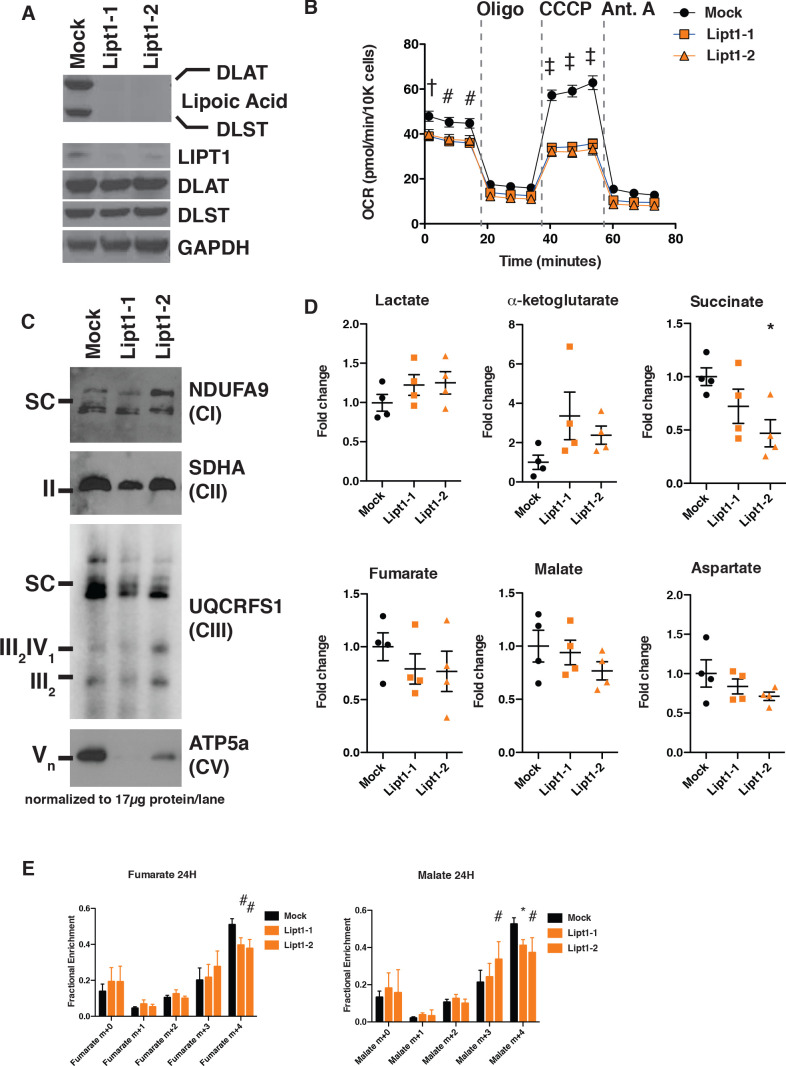
MtFAS mutant phenotypes are not recapitulated by loss of lipoic acid alone.(A) Immunoblot for the indicated proteins in whole cell lysates from Lipt1 mutant and control cell lines. (B) In triplicate experiments, cells of each of the indicated clones were seeded in eight wells of a 96-well seahorse plate and allowed to adhere overnight, then equilibrated and treated with the indicated drugs following standard mitochondrial stress test protocols from the manufacturer to determine Oxygen Consumption Rate (OCR). #=p < 0.01, †=p < 0.001, ‡=p < 0.0001 all comparisons are to GFP control, error bars are SEM. (C) Mitochondrial lysates generated from the indicated cell lines by differential centrifugation were normalized for total protein by BCA assay, incubated with 1% digitonin, then separated by BN-PAGE and immunoblotted with the indicated antibodies. (D) Four biological replicates from mtFAS mutant cell lines or GFP control were grown under standard proliferative conditions and harvested for steady-state metabolomics analysis by LC-MS. Shown are relative pool sizes for the indicated metabolites. *=p < 0.05, error bars are SD. (E) Four biological samples of the indicated genotype were labeled for 24 hr with U13Cglutamine, harvested, and analyzed via GC-MS for the indicated metabolites and their isotopologues. *=p < 0.05, #=p < 0.01, †=p < 0.001, error bars are SD.